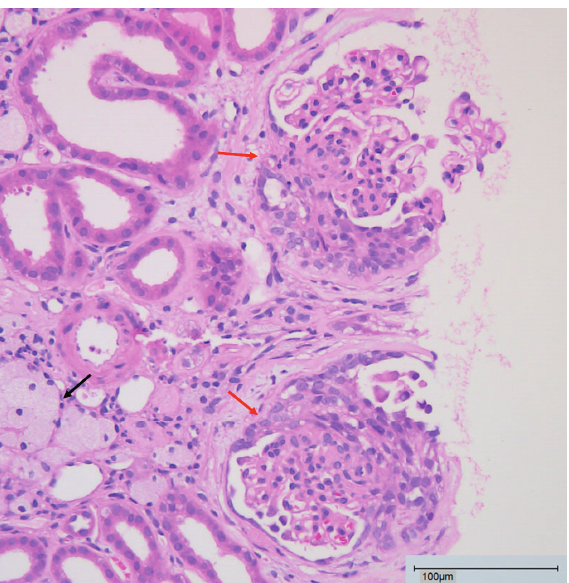
Figure 1: Photomicrography of the patient’s kidney biopsy. It shows segmental sclerosis of 2 glomeruli (red arrows). The black arrow marks interstitial foamy macrophages, often seen in AS as well as in other types of chronic nephrosis. Bar: 100 μ